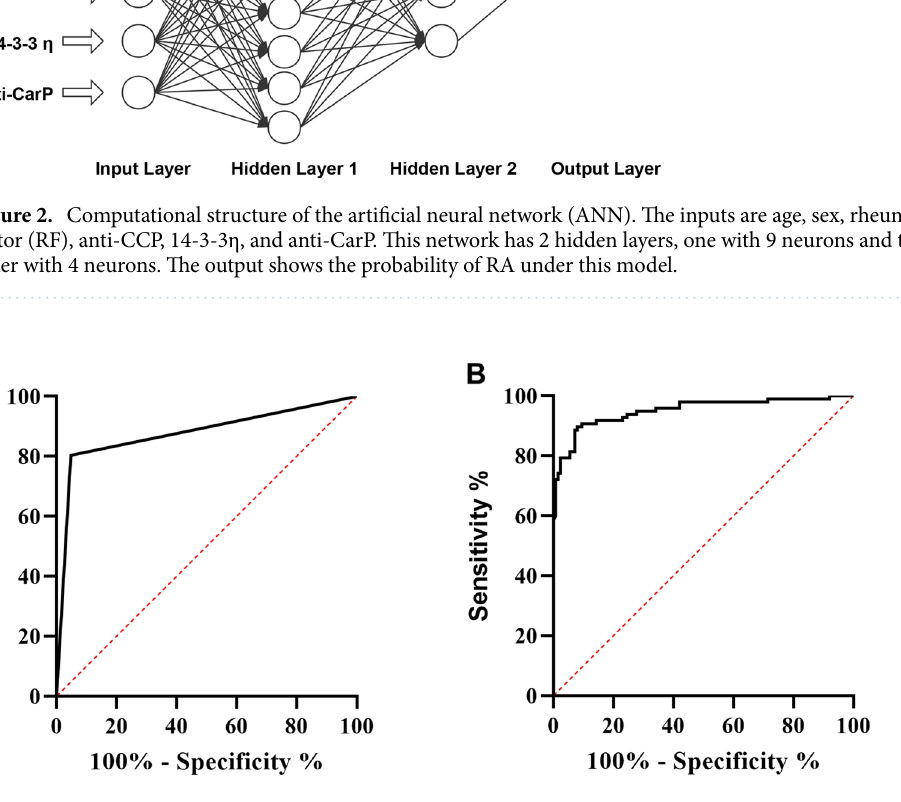
Figure 3. The receiver operating characteristic (ROC) curve of the previous threshold algorithm output ( A ) and the ANN output ( B ). The previous threshold algorithm with an AUC of 0.878 (95% CI: [0.826, 0.930]) and the ANN with an AUC of 0.951 (95% CI [0.921, 0.981]). AUC area under the curve, CI confidence